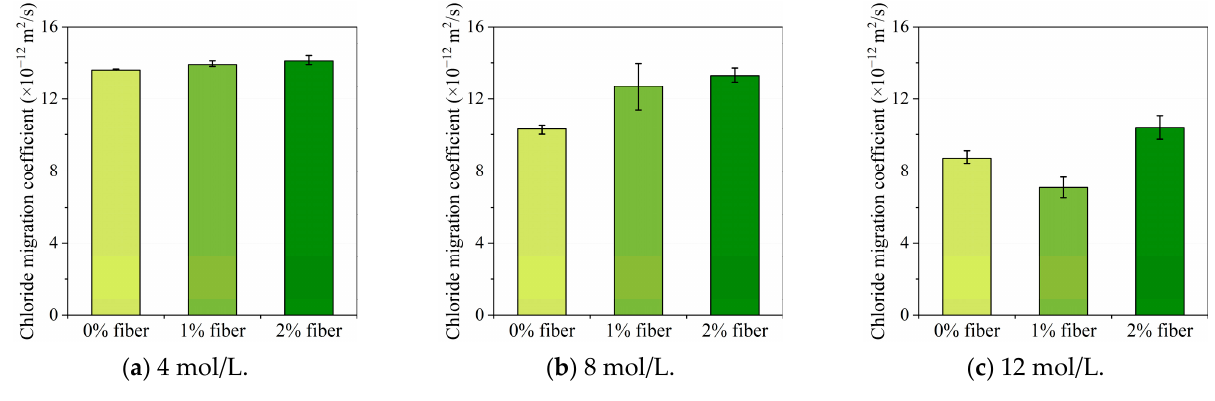
Figure 8. The influence of steel fiber dosage on chloride migration coefficient tested using RCM.